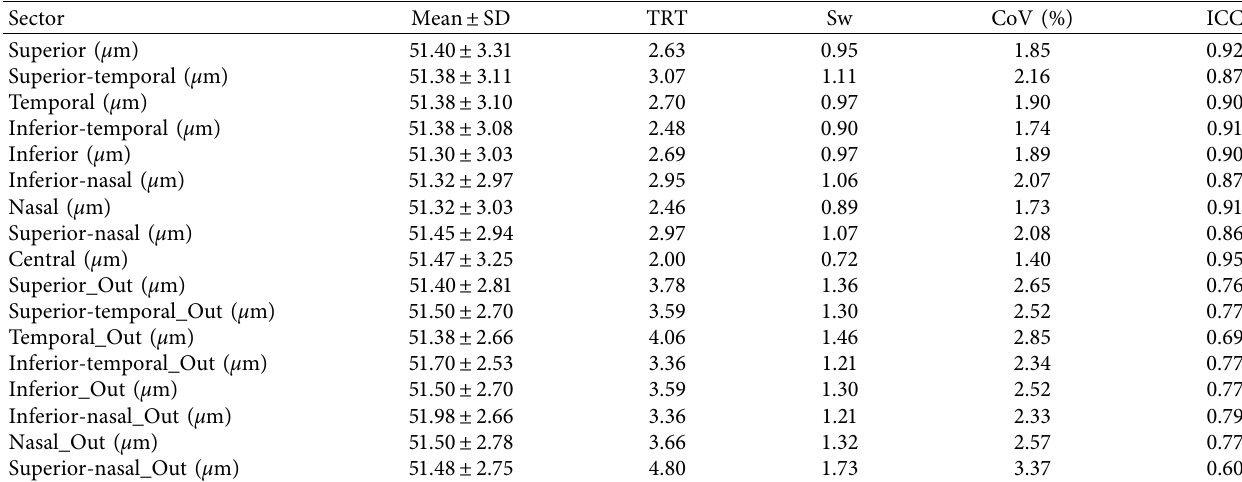
Table 2: Interobserver reproducibility results for ETMs using REVO NX based on the first readings from each session taken by 2 operators in a sample of 40